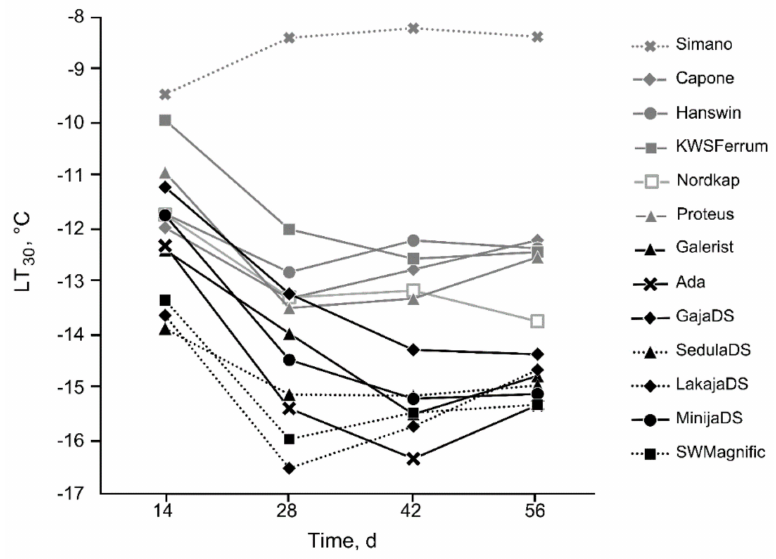
Figure 6. The pattern of freezing tolerance (LT 30 ) accumulation of 13 winter wheat cultivars accli- mated at 2 ◦ C for 14–56 days.